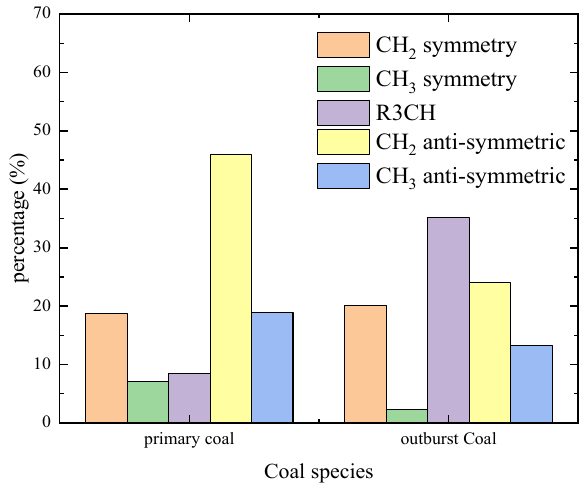
Figure 8. Statistical distribution histogram of CHal.